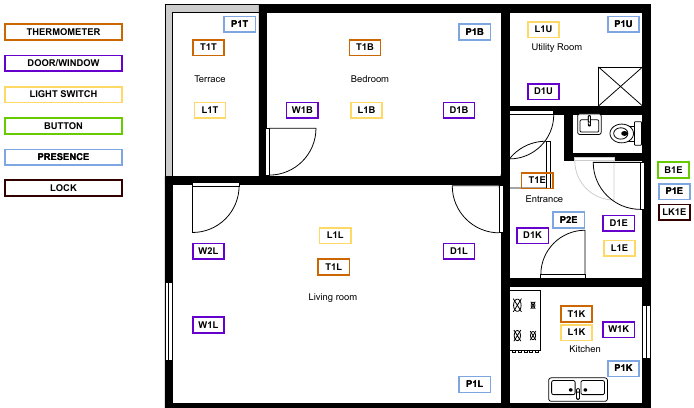
Figure 3. The schema represents the floor-plan of typical domestic environment equipped with various domotic IoT